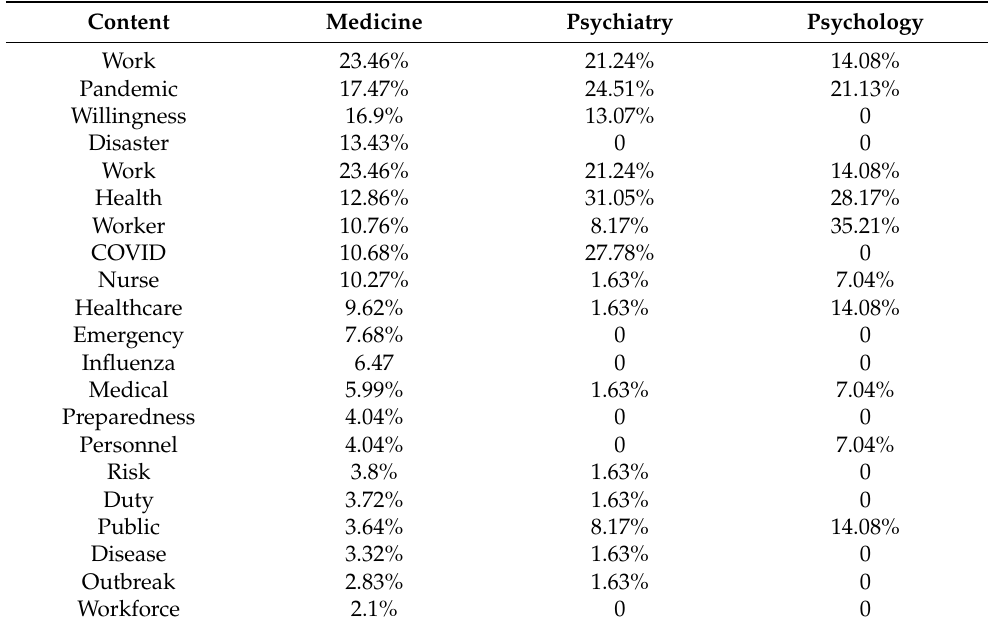
Table 7. Distribution of words and areas.